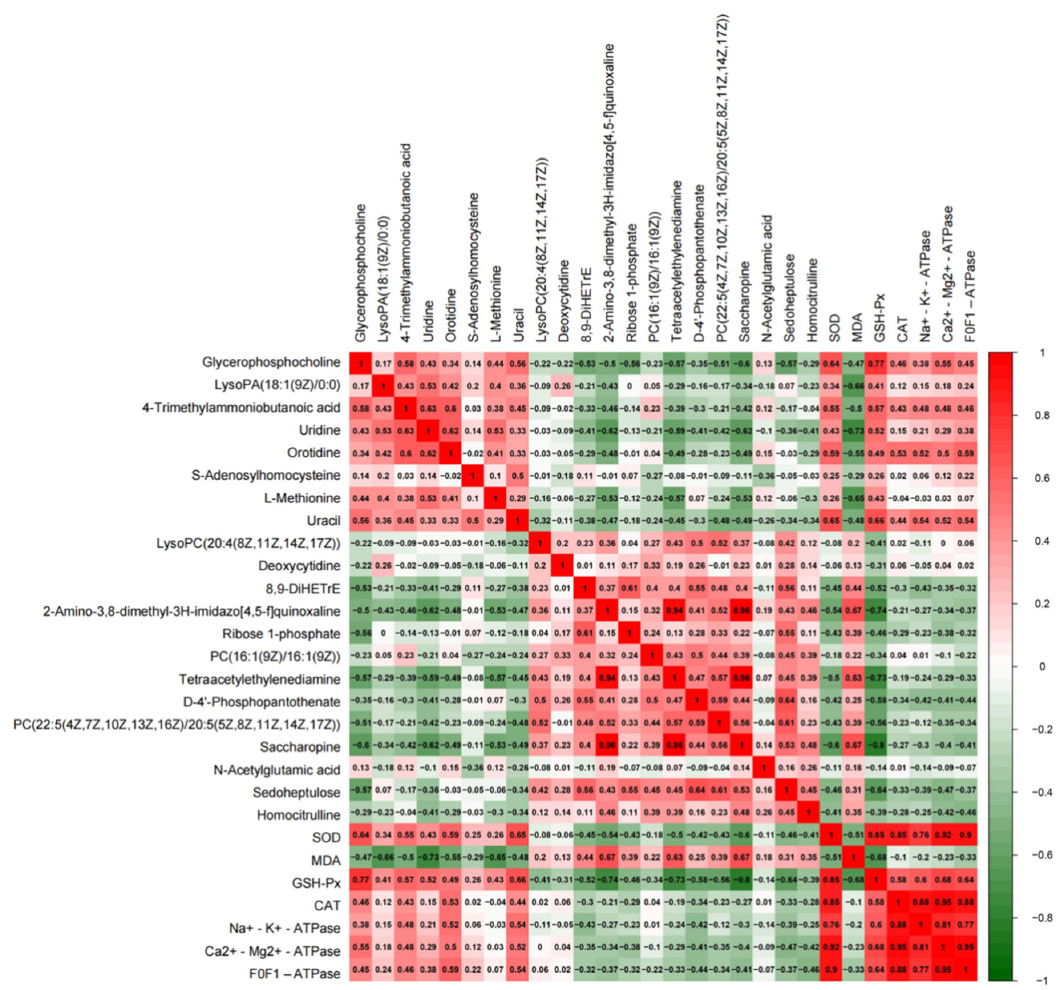
Figure 13. Correlation analysis between potential biomarkers and biochemical indices.